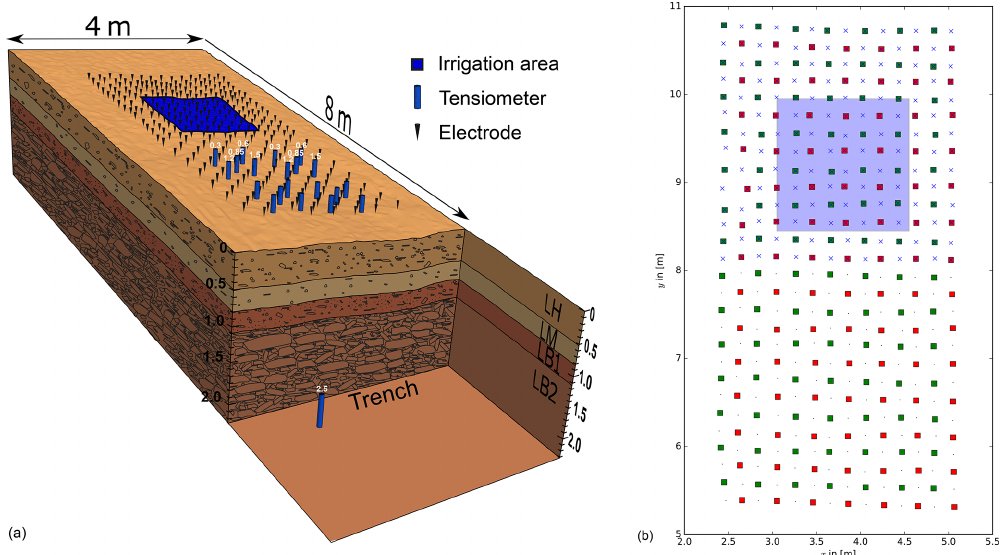
Figure 1. Experimental setup: (a) schematic overview of subsurface layers (LH, LM, LB1, LB2) with measured electrode and tensiometer positions and irrigation area; (b) ERT electrodes, with colours marking the three measuring grids.